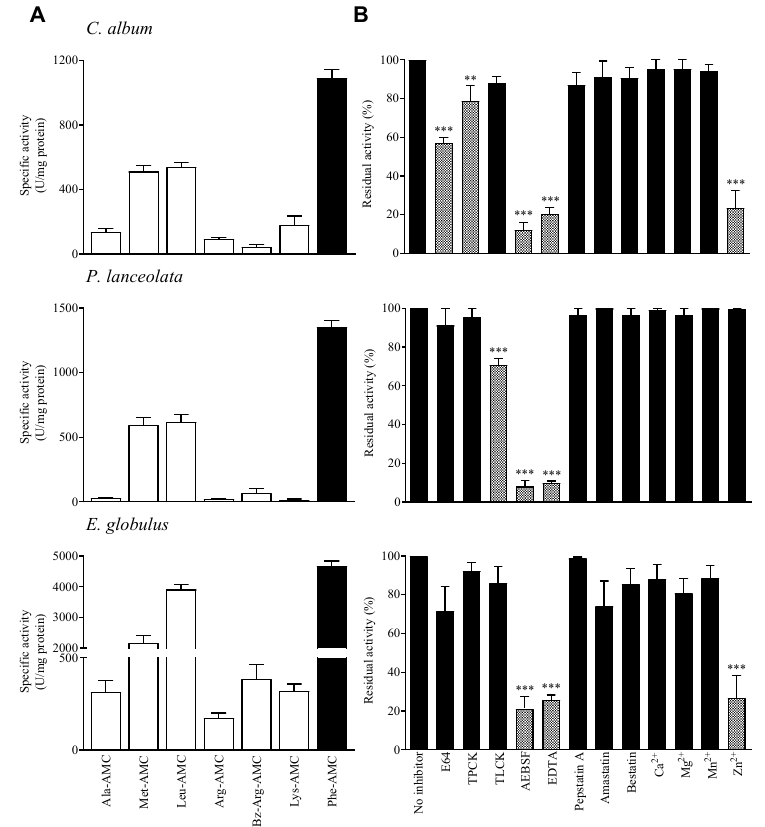
Figure 1. Specificity of pollen proteases from Chenopodium album , Plantago lanceolata and Eucalyptus globulus diffusates. ( A ) Substrate specificity of pollen proteolytic activity. The extracts were incubated for 20 min at 37 ◦ C with 100 µ M peptide-AMC. The black bars indicate the preferred substrate for each pollen diffusate, which was also the substrate used in the inhibition experiments. ( B ) Effect of class-specific inhibitors on the proteolytic activity of the pollen diffusates. The results represent the percentage of residual activity in comparison to the control condition (without inhibitor). The grey bars indicate statistically significant inhibition results. Dunnett’s post-test: *** p < 0.001; ** p < 0.01( n = 3). 1 unit of activity (U) = pmol AMC released / min / mg of